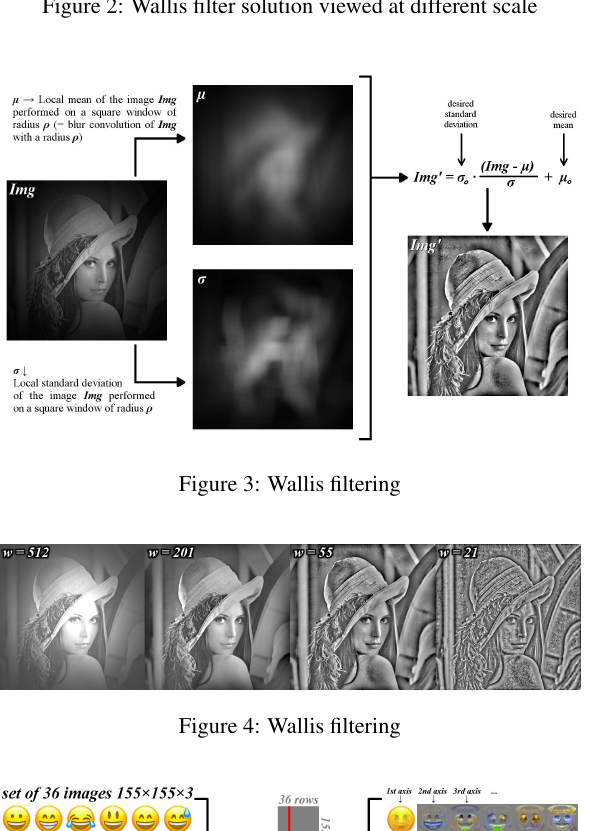
Figure 2: Wallis filter solution viewed at different scale